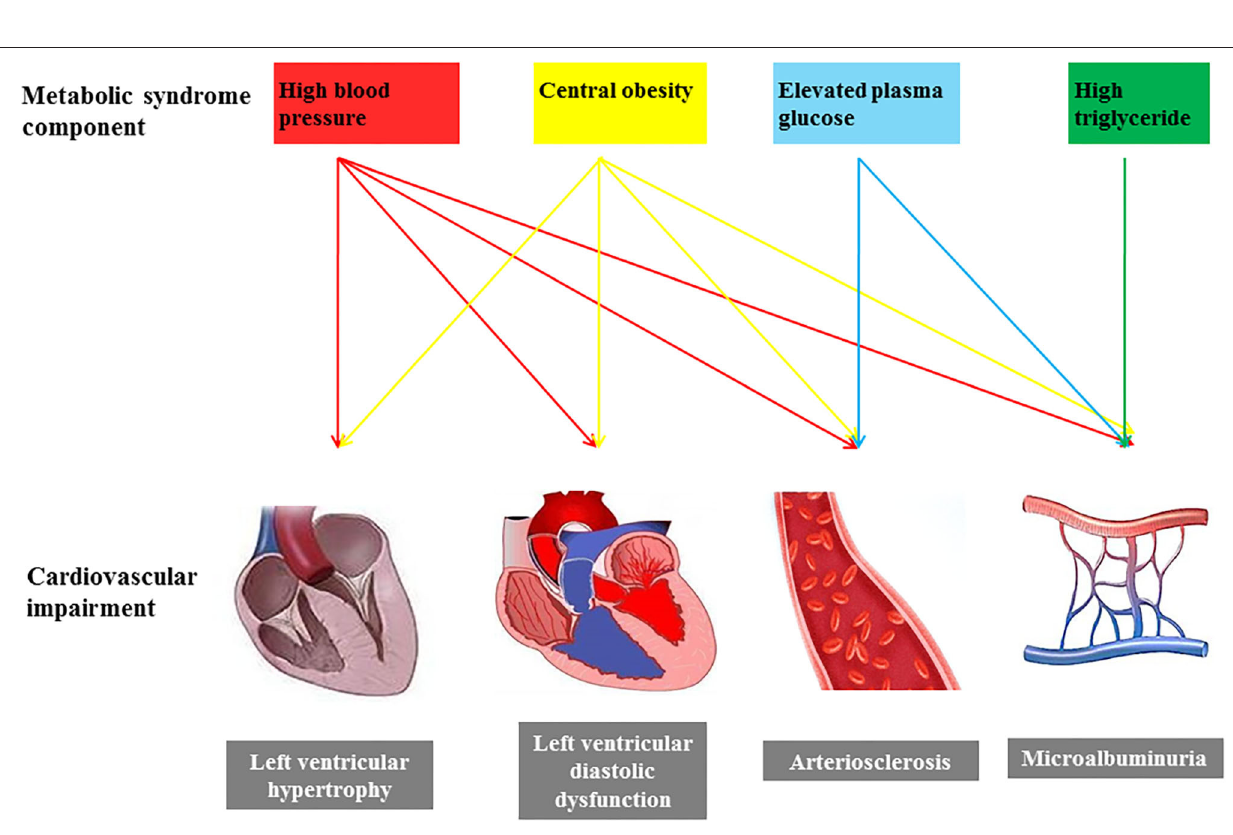
Frontiers in Cardiovascular Medicine |